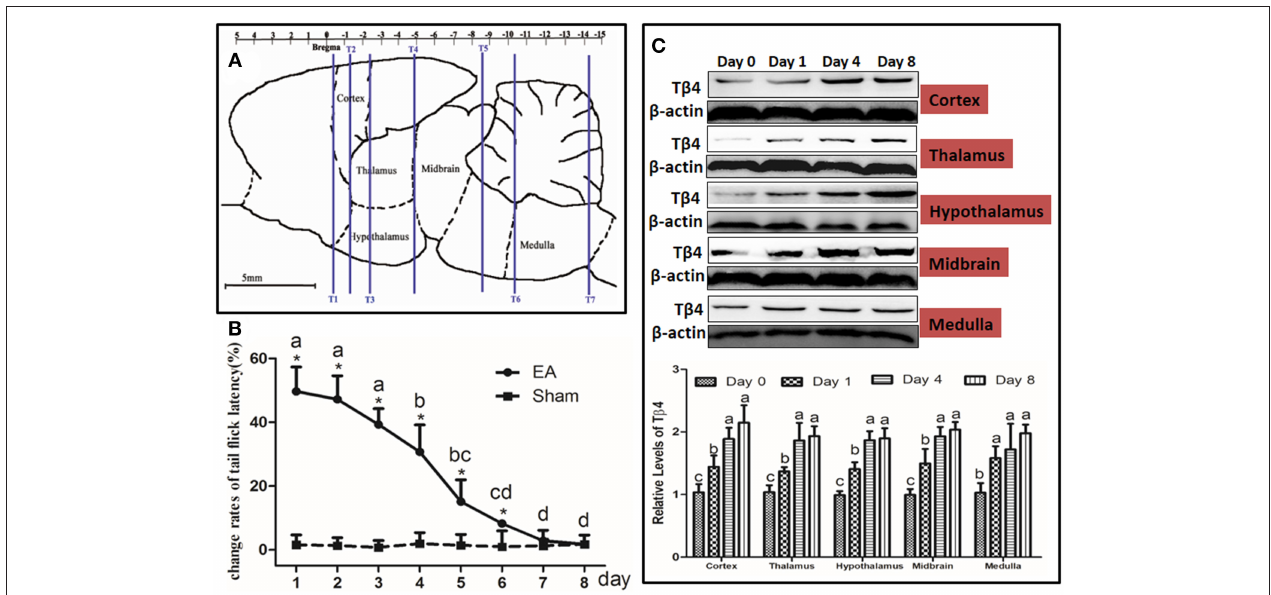
FIGURE 2 | Electroacupuncture (EA)-induced T β 4 expressions in the brain areas and change rates of tail flick latency. (A) Brain areas sampling. The areas to be observed were hypothalamus, thalamus, cortex (sensory region), midbrain and medulla. T1, T2, T3, T4, T5, T6, and T7: marker tubes, show transverse planes at − 0.40, − 1.30, − 2.40, − 4.80, − 8.60, − 10.30, and − 14.2mm rostral to the transverse plane of bregma, respectively. (B) Change rates of tail flick latency after repeated EA (Mean ± SD, %, n = 6). The significance of differences was calculated by a t -test between sham and EA groups or a one-way ANOVA among different time points in EA group followed by Bonferroni’s post-test.* P < 0.05 compared with sham group. The values with different letters (a–d) within the EA treatment differ. (C) The T β 4 expressions in the brain areas after repeated EA (Mean ± SD, n = 6). The values with different letters differ significantly among different time points